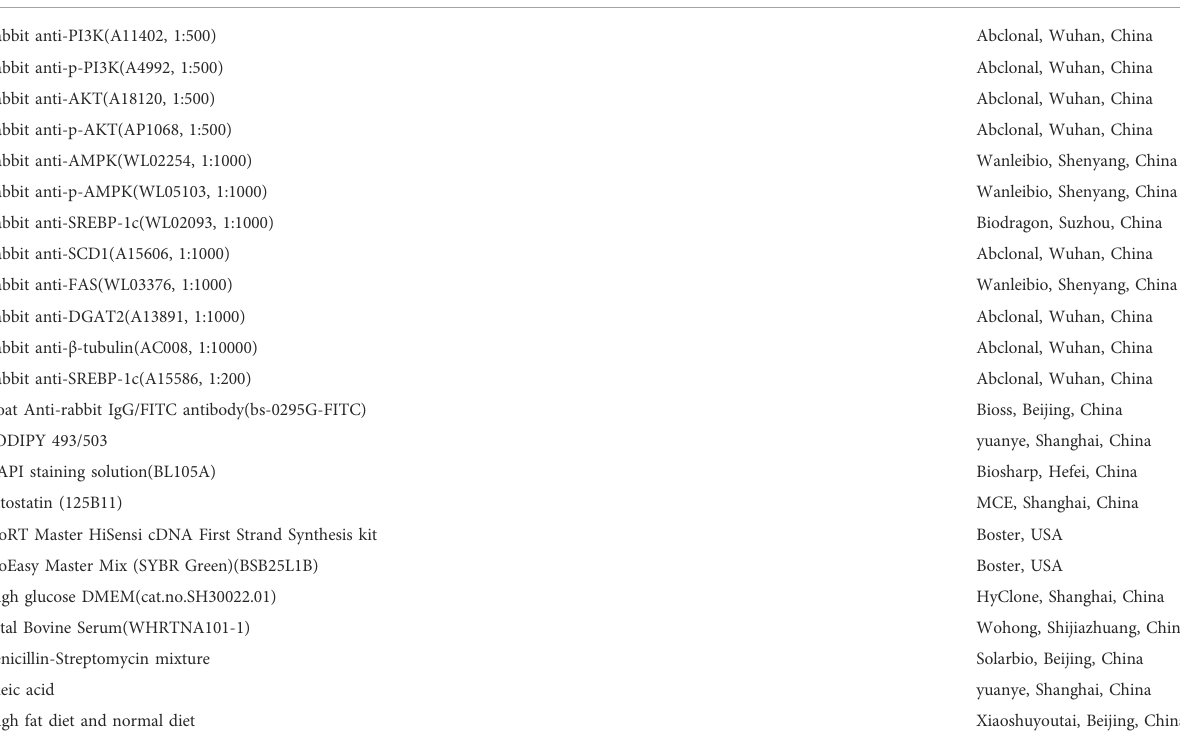
TABLE 4 Antibodies and